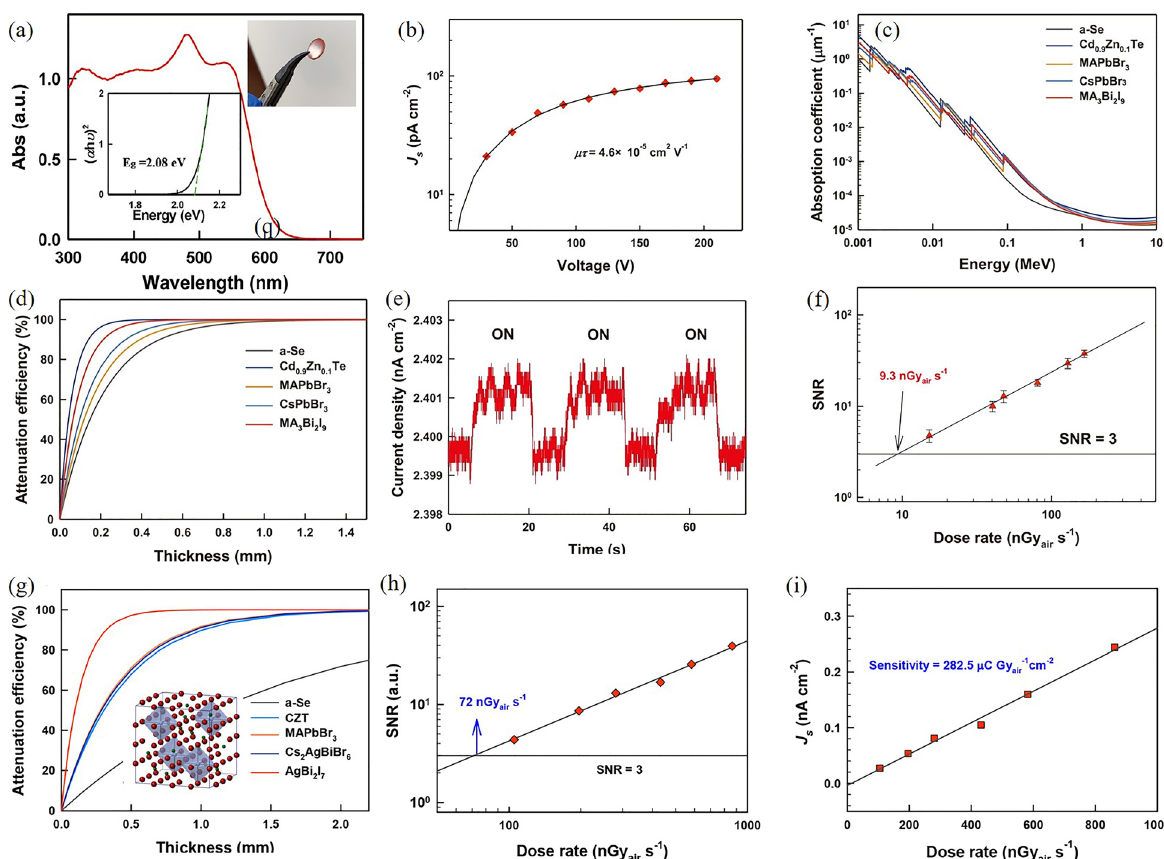
Figure 14: 0D Bi-based perovskite variants (MA 3 Bi 2 I 9 and AgBi 2 I 7 ) for X-ray detection. (a)AbsorptionspectrumofpolycrystallineMA 3 Bi 2 I 9 wafer.Inset:Taucplottoestimatethebandgapassumingadirectbandgap.(b)Estimation of the μτ product of the polycrystalline MA 3 Bi 2 I 9 wafer by photoconductivity measurement. (c) Photon energy-dependent X-ray absorption coef fi cients of a-Se, Cd 0.9 Zn 0.1 Te (CZT), MAPbBr 3 , CsPbBr 3 , and MA 3 Bi 2 I 9 . (d) Comparisonof the thickness-dependent attenuation ef fi ciencies of a-Se, CZT, MAPbBr 3 , CsPbBr 3 , and MA 3 Bi 2 I 9 semiconductors towards X-ray photons of 35.5 keV energy.(e) I – t measurement of the MA 3 Bi 2 I 9 polycrystalline wafer under an electric fi eld of 700 V cm − 1 and an X-ray dose rate of 15.2 nGy air s − 1 . (f) SNR versus dose rate of the device under 700 V cm − 1 electric fi eld. The error bars representstandard deviations. A detection limit of 9.3 nGy s − 1 can be derived from the fi tting line at an SNR benchmark of 3. Adapted with permission. Copyright 2020, Wiley-VCH Verlag [164]. (g) Attenuation ef fi ciency of a-Se, CZT, MAPbI 3 , dependentsignal-to-noiseratio(SNR)ofthedevice.Thedetectionlimitof72nGys − 1 isderivedfromtheslopeofthe fi ttinglinewithasignal-to- noise ratio of 3. (i) X-ray dose rate-dependent signal current density ( J s ) of the device. The X-ray sensitivity of the device is derived from the slope of the fi tting line. Copyright 2020, the Royal Society of